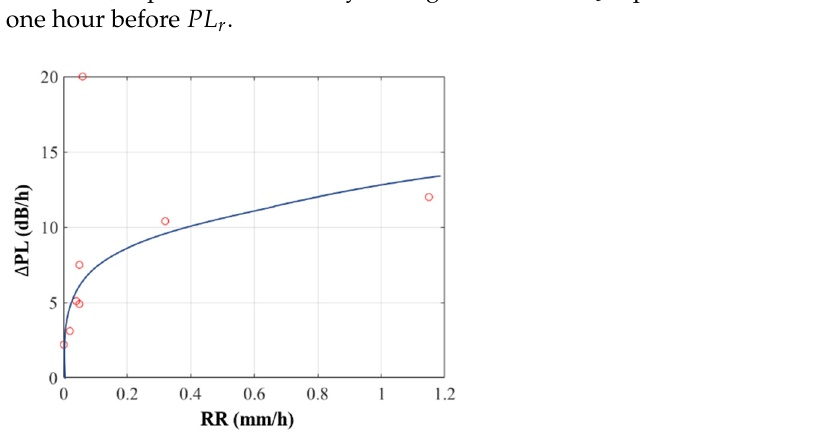
Table 6. The parameters of the additional experiment results during rainfall.